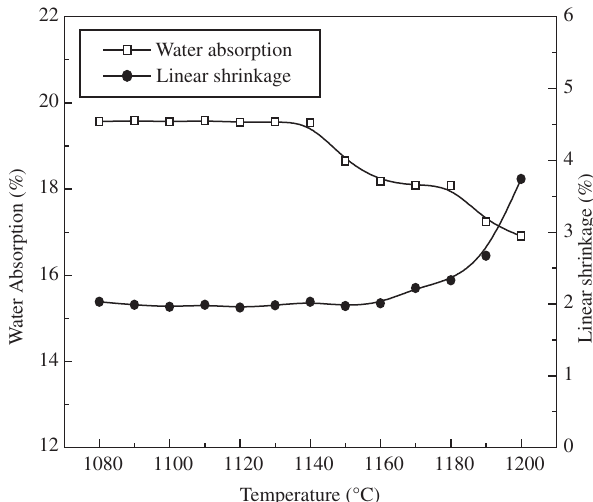
Figure 6. Gresification curve of the ceramic paste.